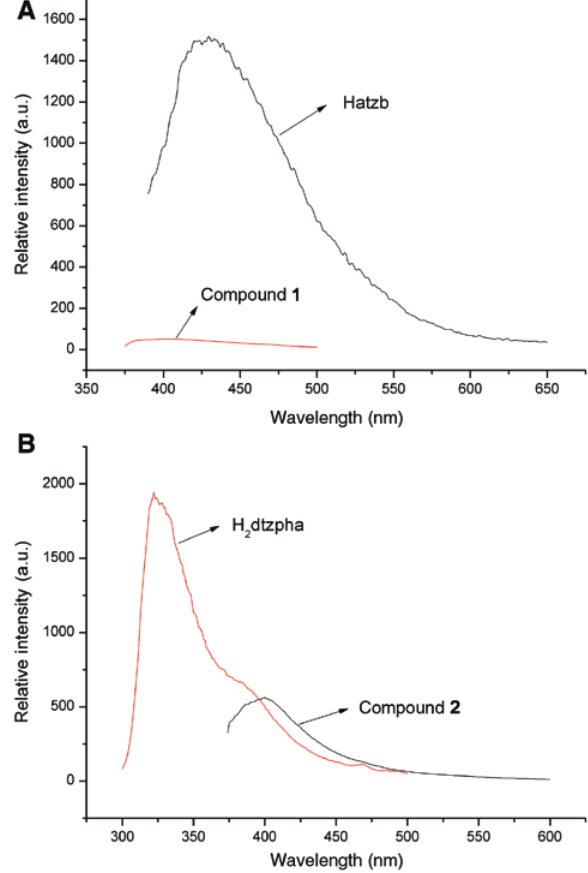
Figure 7: (A) Emission spectra of compound 1 and 5-aminotetra- zole-1-propionic acid in the solid state at room temperature (for 5-aminotetrazole-1-propionic acid λ (B) Emission spectra of compound 2 and 1,3-di(tetrazol-5-yl) benzene-N2,N2 ′ -diacetic acid in the solid state at room temperature [for 1,3-di(tetrazol-5-yl)benzene-N2,N2 ′ -diacetic acid λ = 336 nm]. for 2 λ ex